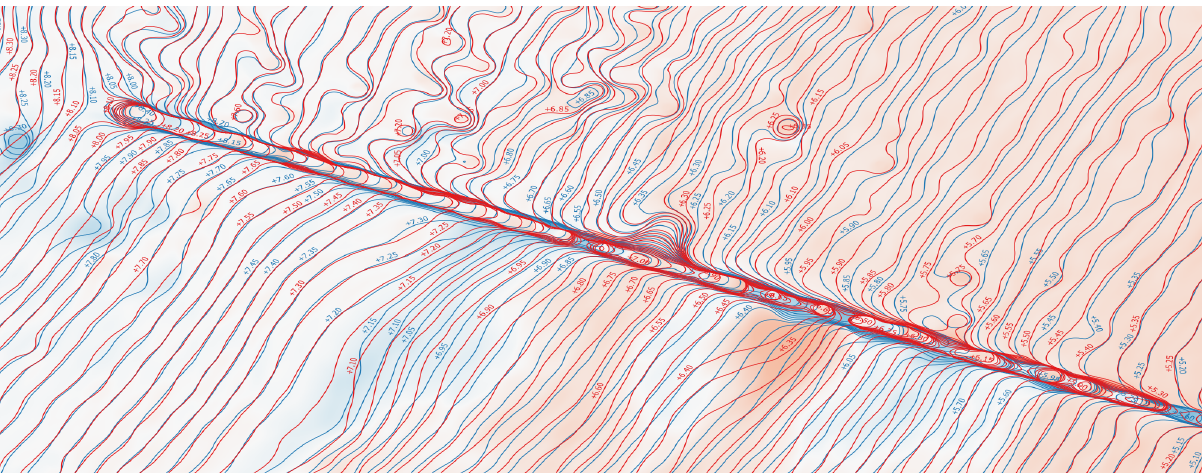
Figure 21 - Erosion (Red Areas) / Accretion (Blue Areas) over the 48-Hour Period between 31/07/2020 and 02/08/2020. The Red Contours denote the first survey and the blue contours denote the second survey (contours are at 5cm intervals). Northeast of the groyne, the pink area denotes a typical sediment loss of 5cms, probably due to longshore drift; while south of the groyne there are bands of erosion and accretion, i.e. the groyne has disrupted the prevailing longshore drift. The area of most erosion (red patch) exhibits a 3-contour interval or 15cms loss of sediment and pebbles.